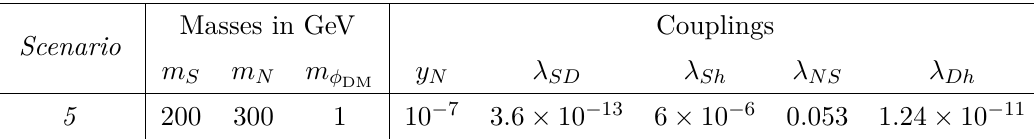
Table 6 . The choices of masses and couplings for Scenario-5